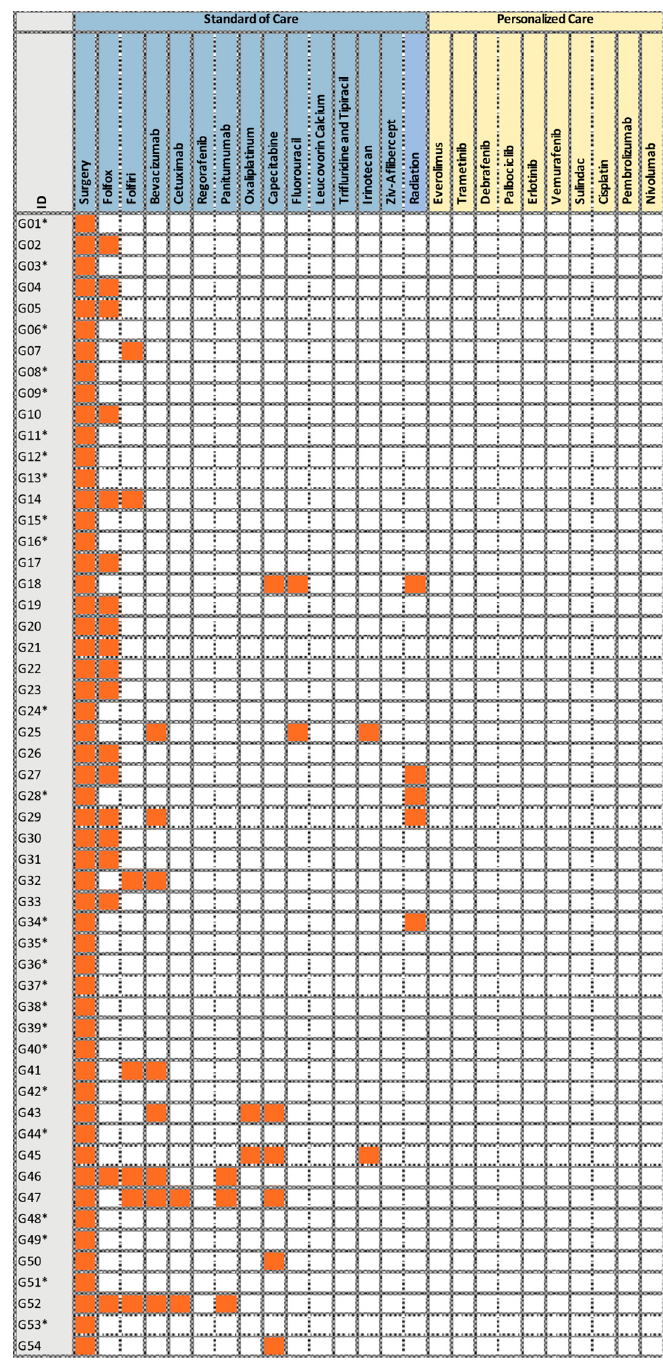
Figure 3. Treatments received by the German patients (G01–G54) in 2003–2010. The asterisk (*) marks patients who received chemotherapy at external oncological practices.